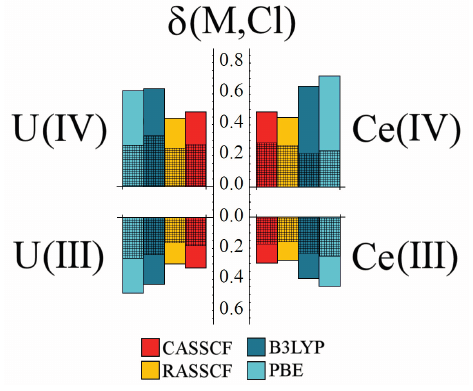
Figure 7. Comparison of M–Cl delocalisation index, δ , for tri- and tetravalent uranium and cerium hexahalides. Cross-hatched regions correspond to the gerade contributions to δ . All values are given in